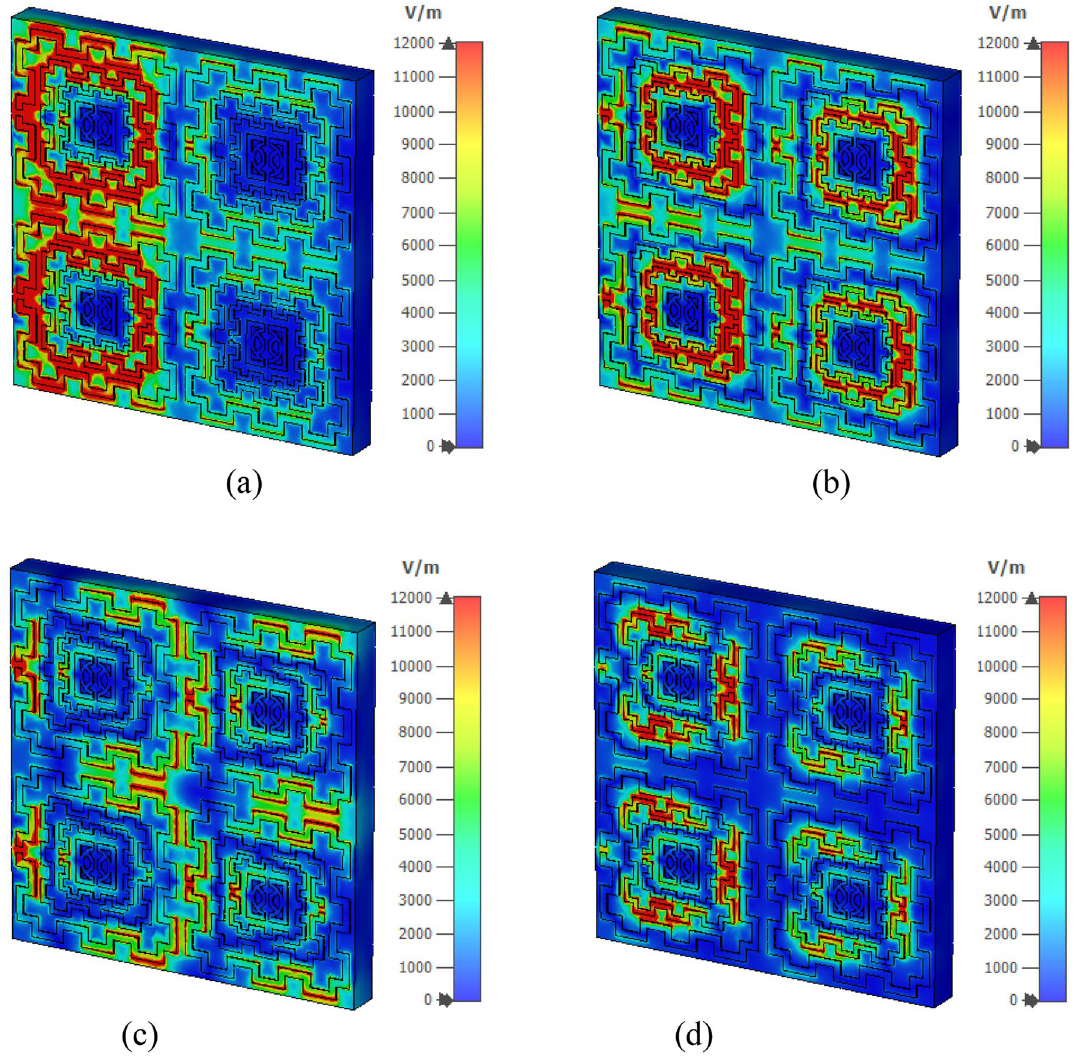
Figure 25. Electric field distribution in 2 × 2 array at ( a ) 2.63 GHz, ( b ) 4.28 GHz, ( c ) 8.9 GHz, and ( d ) 13.7 GHz. (CST STUDIO SUITE 2019, https:// www. 3ds. com/ produ cts- servi ces/ simul ia/ produ cts/ cst- studio- suite) 28 .